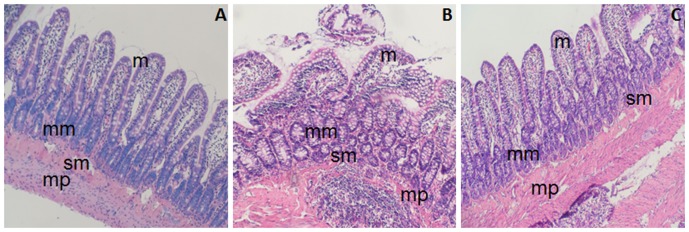
Hematoxylin and eosin staining of rat ileal tissue (HE, ×200) from different groups.A: blank (normal) group; B: CCl4-treated rats receiving the vehicle only; and C: oxymatrine treatment group. m: mucosa, mm: muscularis mucosae, mp: muscularis proparia, and sm: submucosa.